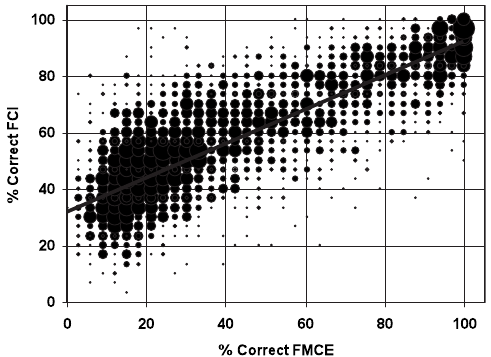
FIG. 3. A bubble plot of % correct on the FCI vs % correct on the FMCE for all scores. There are 3319 pairs of scores. The slope of the best fit line through the data is 0.54 and the y intercept is 36. The correlation coefficient is 0.78. Two students had a score of 20% on the FCI and 3% on the FMCE. Seventeen students had a score of 97% on the FCI and a score of 100% on the